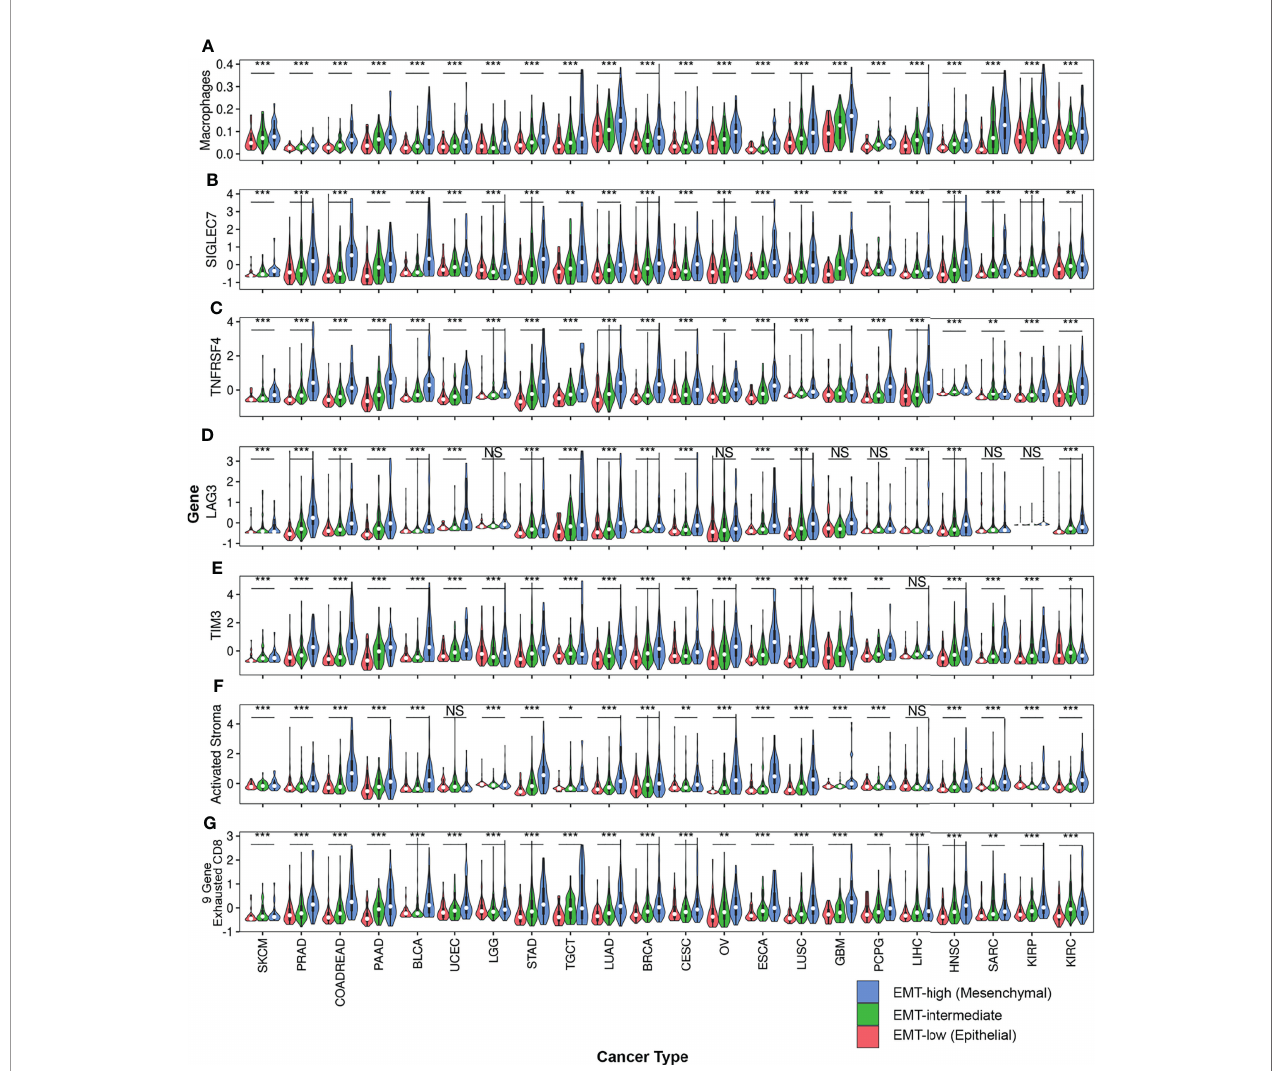
FIGURE 5 | Violin plots comparing expression of various TIME markers among all three EMT groups across all cancer types: Violin plots of (A) Macrophages, (B) SIGLEC7, (C) TNFRSF4, (D) LAG3, (E) TIM3, (F) Activated Stroma and (G) 9-Gene Exhausted CD8+ T-cells are represented. One-way anova was used to compare the expression of these TIME markers. Asterisks (*) indicate signi fi cance based on p-values. *** represents p-value < 0.001, ** represents p-value between 0.001 to <0.01, * represents p-value between 0.01 <0.05, and fi nally NS represents non-signi fi cant